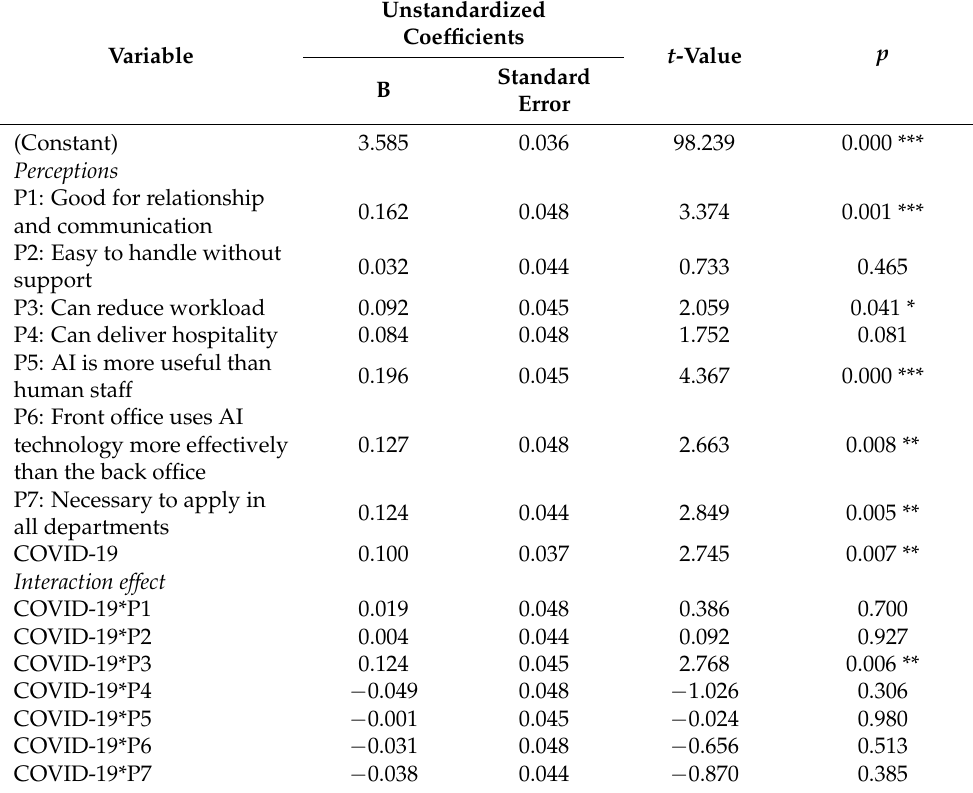
Table 5. Regression results with work intention as the dependent variable.